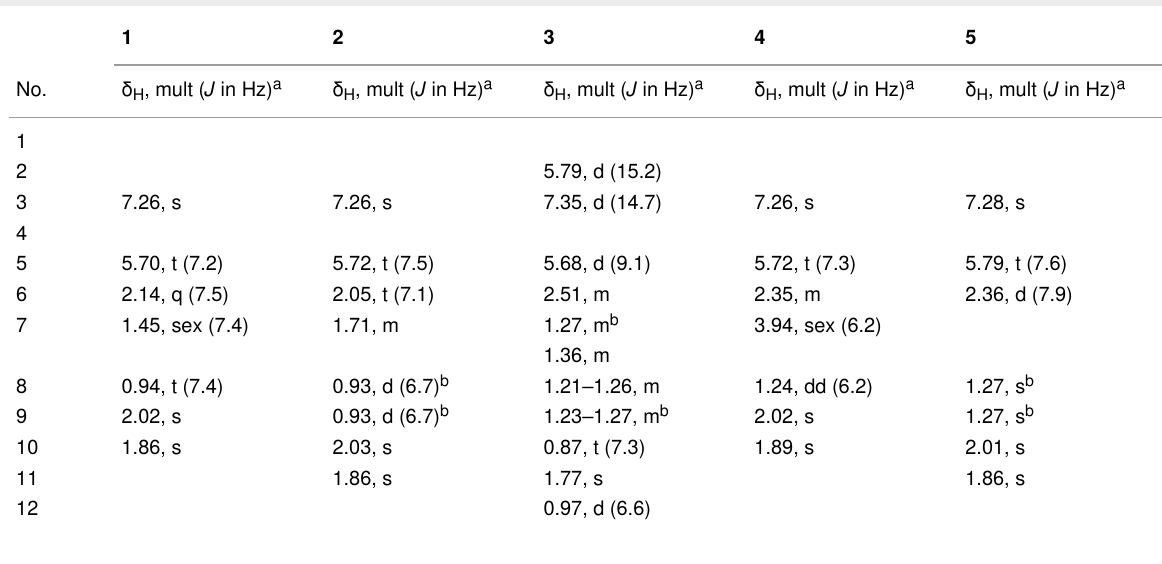
Table 2: 1 H NMR data for 1 – 5 in CDCl 3